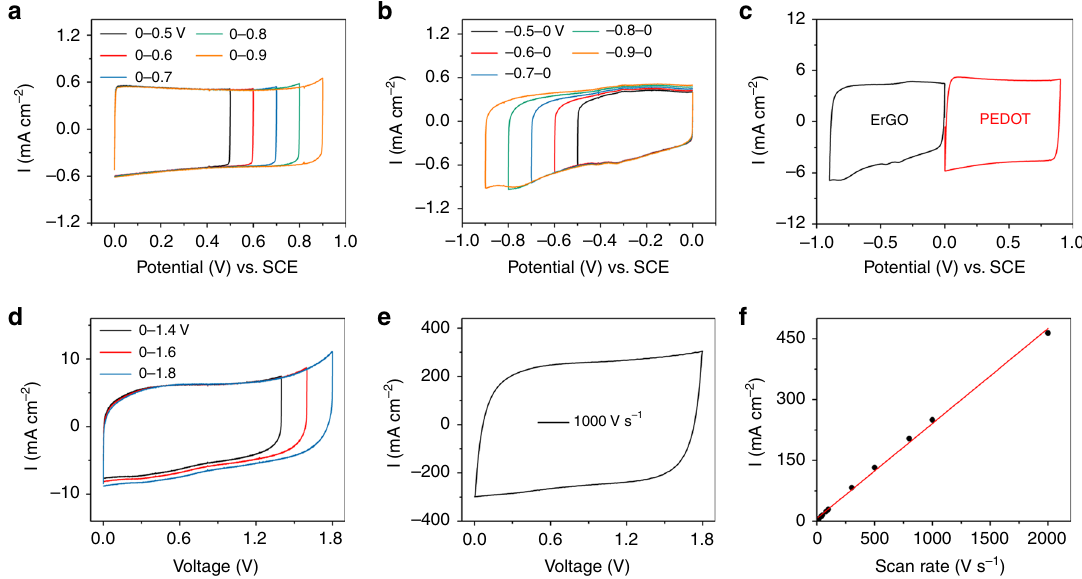
Fig. 2 The cyclic voltammetry performances of single electrode and unit. a , b Cyclic voltammetry (CV) curves of the poly(3,4-ethylenedioxythiophene) (PEDOT) positive electrode ( a ) and electrochemically reduced graphene oxide (ErGO) negative electrode ( b ) in different potential ranges at scan rate of 1 V s − 1 . c CV curves of PEDOT and ErGO electrodes in separate potential windows at scan rate of 10 V s − 1 . d CV curves of the aqueous hybrid electrochemical capacitors (AHECs) in different voltage ranges at scan rate of 10 V s − 1 . e CV curves of the AHEC at scan rate of 1000V s − 1 . f Plots of discharge current density versus scan rate of the AHEC. Source data are provided as a Source Data fi